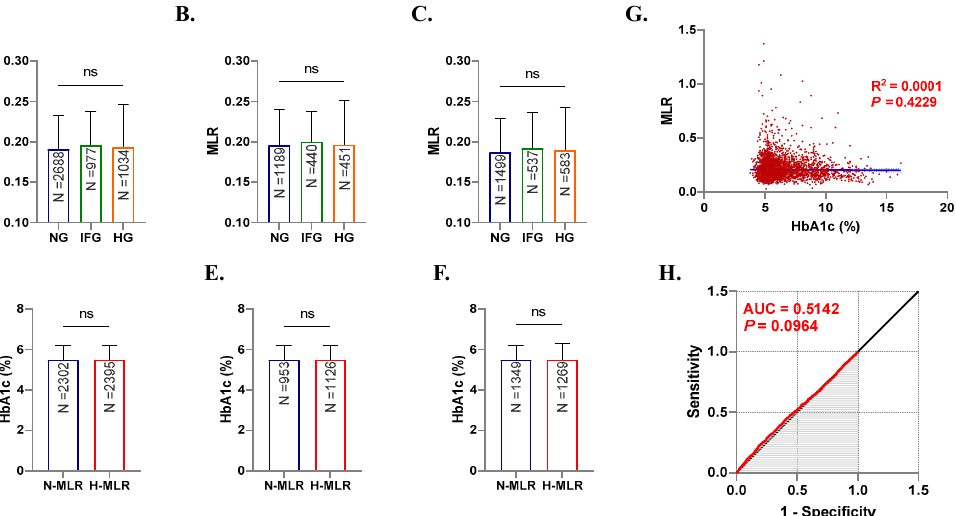
Figure 4. Patterns of MLR in light of HbA1c levels. Medians + IQR of MLR in both genders ( A ), males ( B ), and females ( C ), and of HbA1c in both genders ( D ), males ( E ), and females ( F ). Spearman’s correlation ( G ) and ROC curve ( H ) of MLR and HbA1c. ns indicates not